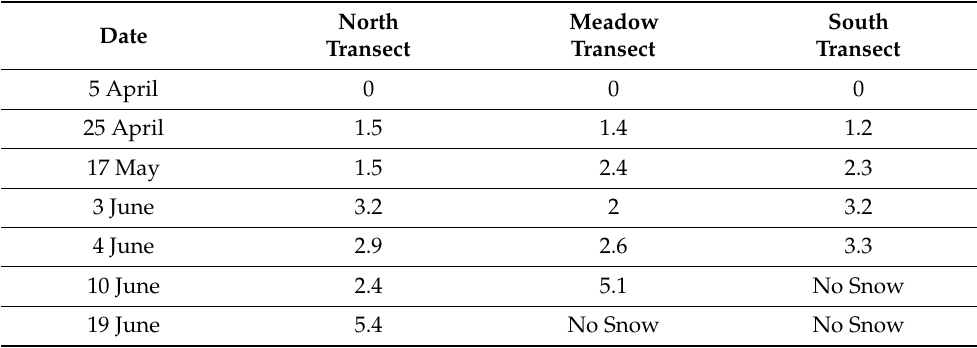
Figure 11. ( a ) North Transect LWC averaged along 9 m intervals for morning, midday, and evening surveys, plotted with distance along transect. Explainable outliers were removed and are represented as breaks in the line. ( b ) Boxplots of ΔLWC along the North Transect from morning to midday and from midday to evening. Positive values represent an increase in LWC, and negative values represent a decrease in LWC. The 3 June evening survey GPR track exhibited poor GPS quality and was not included in the analysis. Table 3. Morning survey median vol. % LWC by transect.